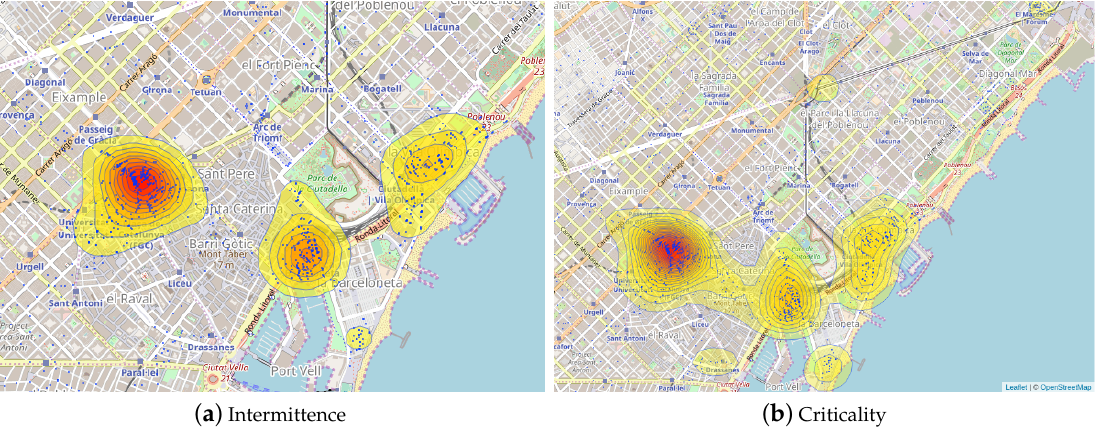
Figure 6. Heat maps representing intermittence and criticality values in Barcelona at the hourly time slot (between 11:00 a.m. and 12:00 a.m.). maxdist = 0.5 km, and time slot size = 1 h. full-th = 3.